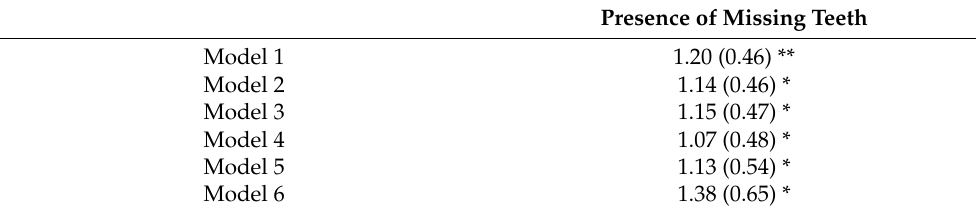
Table 5. Crude and adjusted logistic regression models and correspondent standard error of fre- quently affected OHIP-14 total score towards the presence of missing teeth ( n = 93).